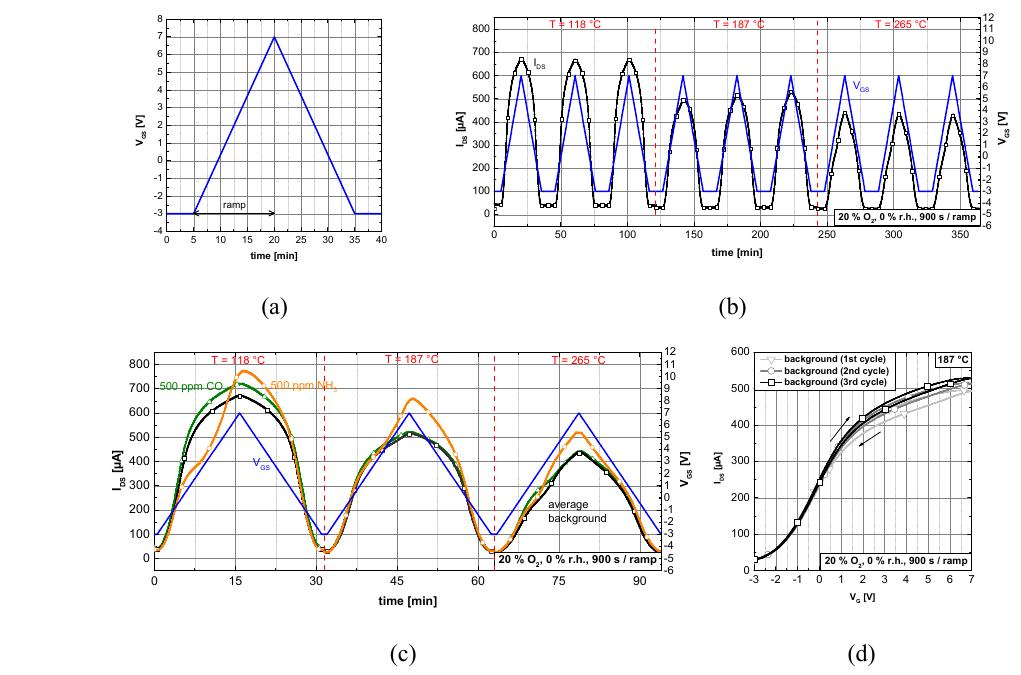
Figure 3. Visualization of a gate bias cycle (a) , an excerpt from an actual measurement showing the gate potential (blue) and sensor response (black) at three di ff erent temperatures in background (black, rectangles) (b) and with ammonia (orange, circle) or CO (green, triangles) (c) , and the absolute signal of three cycles in background (d) . One hysteresis curve consists of one ramp up and one ramp down.